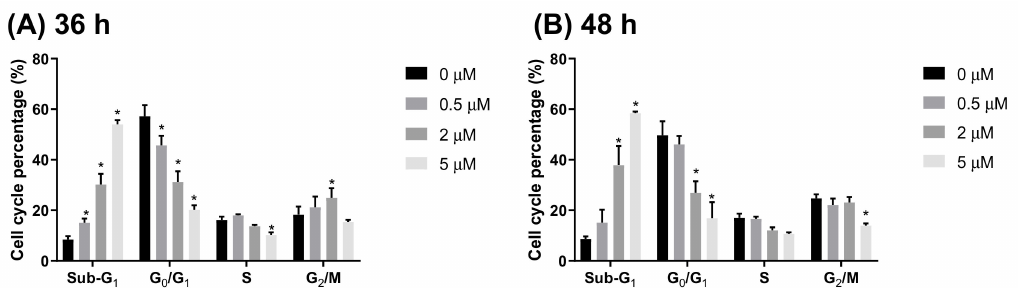
Figure 4. Cell cycle change after HCD treatment. Caco-2 cells were stained by propidium iodide after ( A ) 36 h and ( B ) 48 h of HCD treatment, and further analyzed by fluorescent intensity by flow cytometry. Data ( n = 3) were represented as mean ± SD. * p < 0.05; ** p < 0.01; *** p < 0.001, as compared with the untreated control (0 µ M).